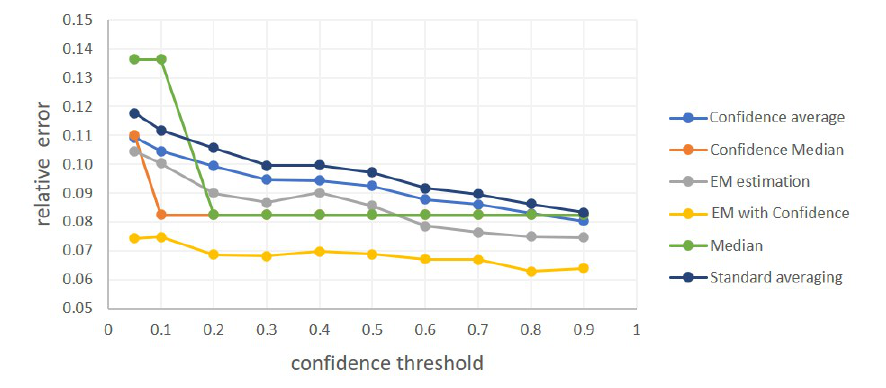
Figure 6. Robust estimation methods’ relative error as a function of the confidence threshold t for β =